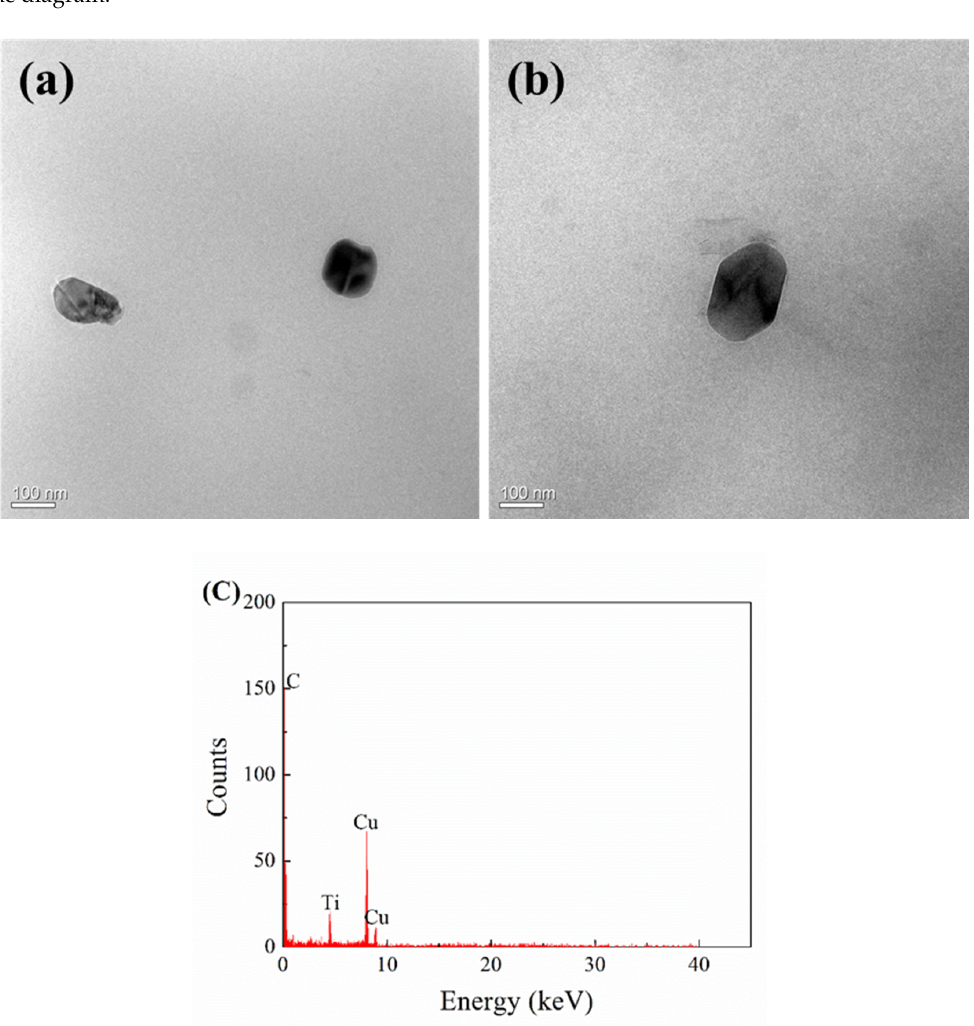
Figure 5. TEM micrographs of the ( a ) C-EC, ( b ) C-EC / TPU, and ( c ) EDX